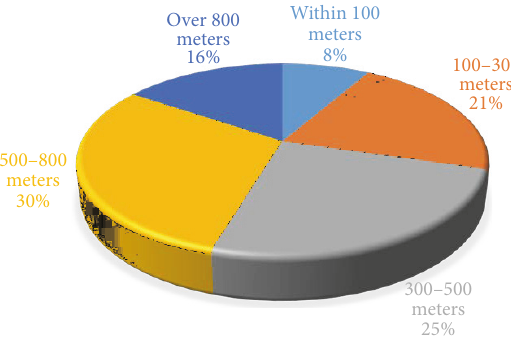
Figure 1: Statistical distribution of the maximum acceptable